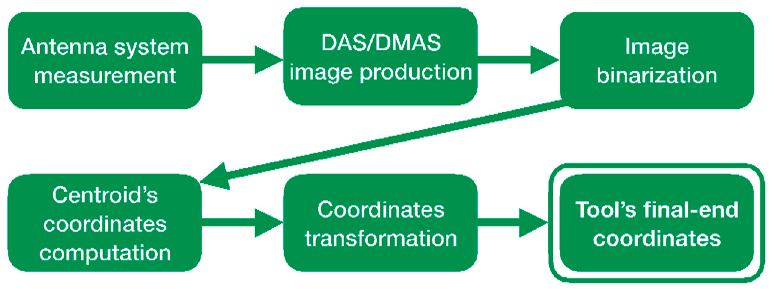
Figure 16. Scheme of the coordinate detection process.